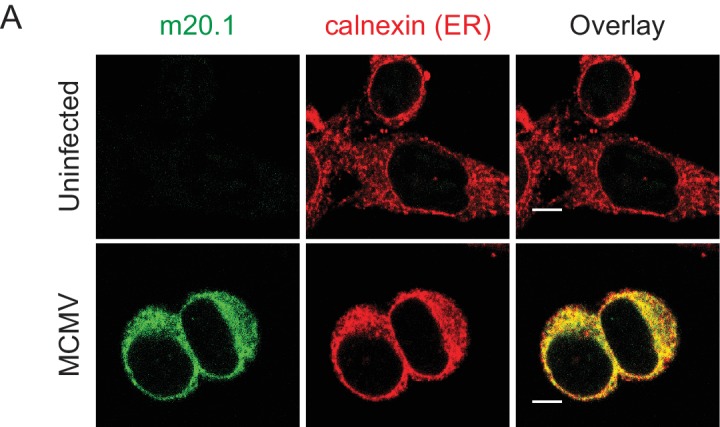
MCMV m20.1 protein resides in endoplasmic reticulum.Confocal images of B12 mouse cell line infected with 3 PFU/cell of WT MCMV for 20 hr or left uninfected. Cells were stained with anti-m20.1 antibody followed by anti-rat IgG F(ab')2-FITC and with anti-mouse calnexin followed by anti-rabbit IgG F(ab')2-TRITC. Scale bar: 10 μm.